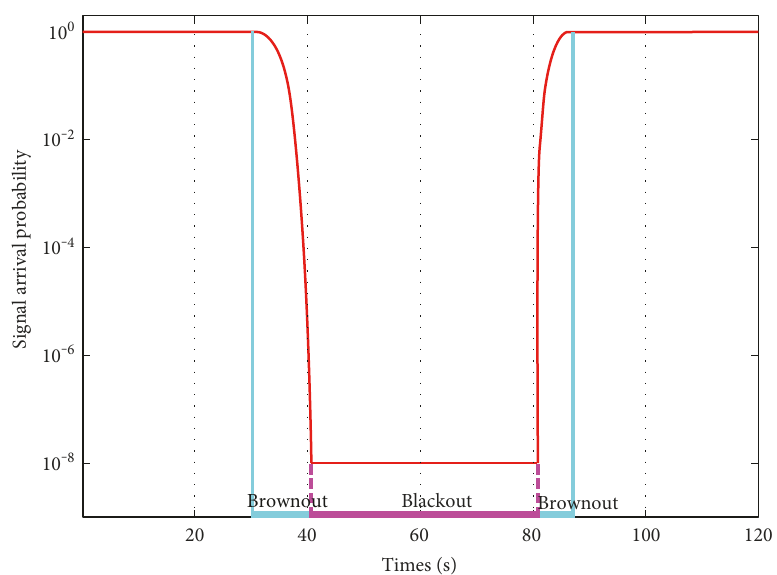
Figure 5: Probabilities of the received signal during Mars atmospheric entry.